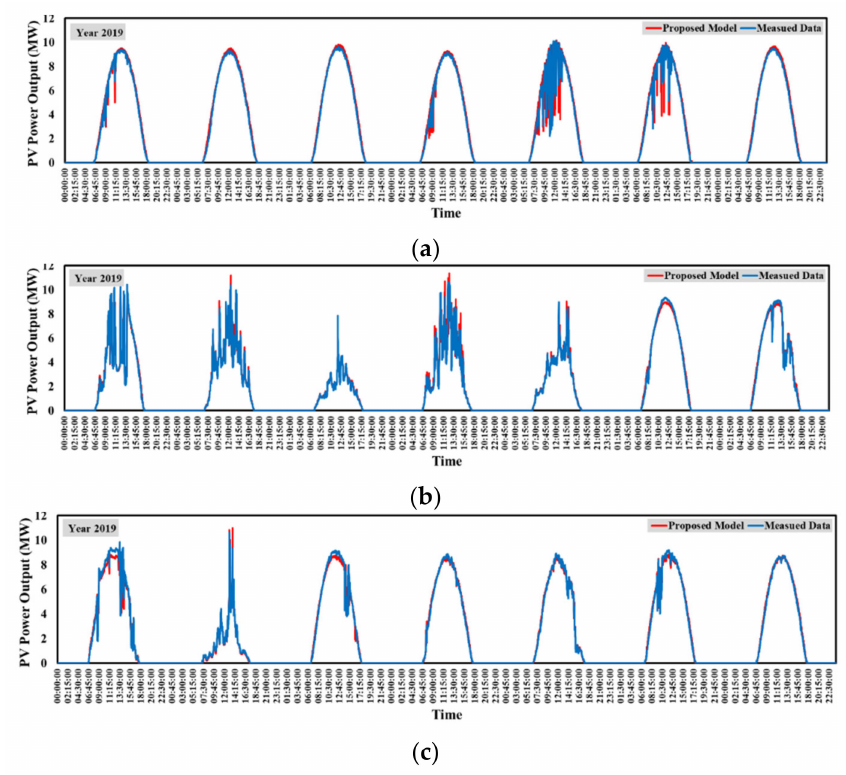
Figure 14. The proposed model and the measured data of the PV power output in the three seasons. ( a ) In the summer; ( b ) in the rainy season; ( c ) in the